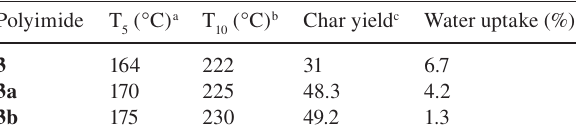
Table 2 Thermal behaviors and water uptake of neat PA 3 and PA- nanocomposite fi lms 3a and 3b .